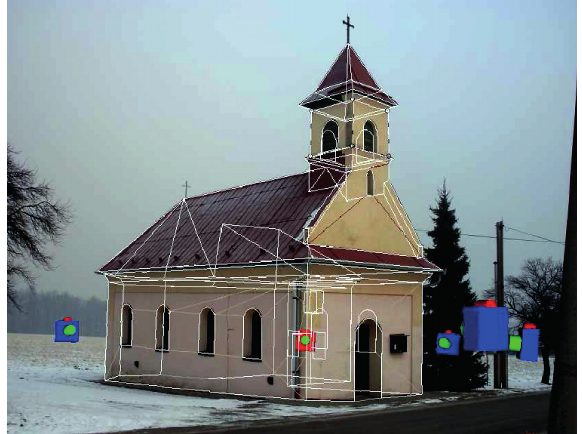
Fig. 11. 3D model of the Saint Hedwig Chapel (3D